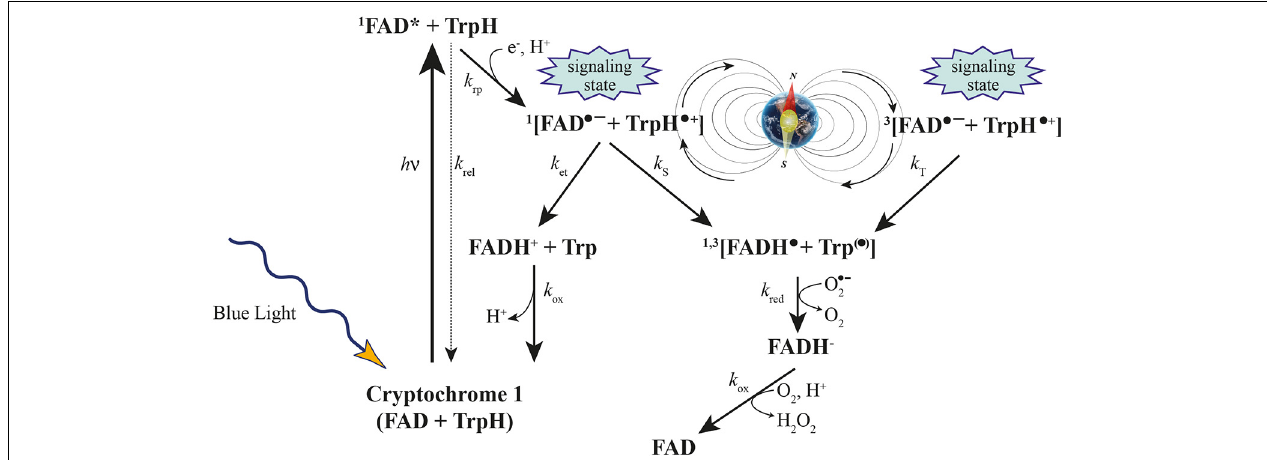
(1) and triplet (3) overall electron spin states by coherent geomagnetic field-dependent interconversions. Under aerobic conditions, FADH • slowly reverts back to the initial inactive FAD state through the also inactive FADH − state of the flavin cofactor (Modified from Occhipinti et al.,